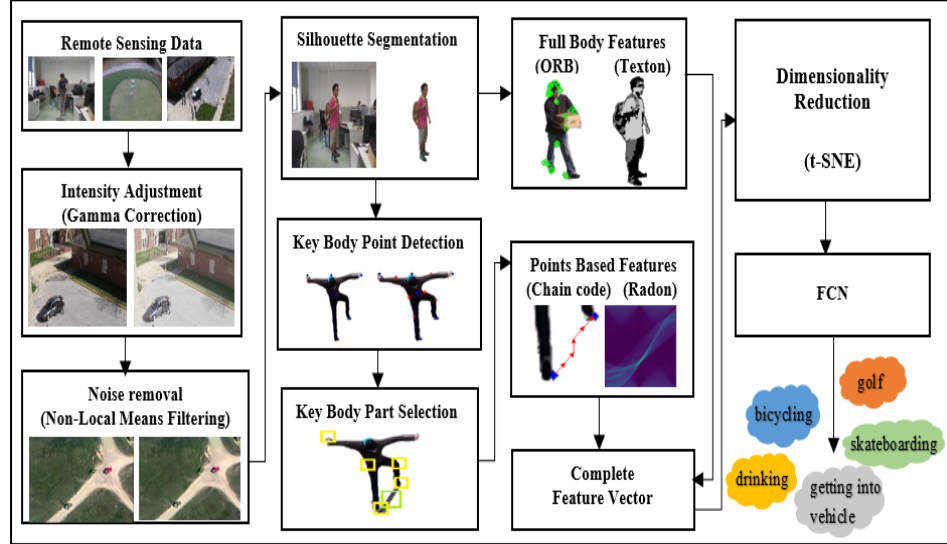
Figure 1. The architecture of the proposed HOI system.